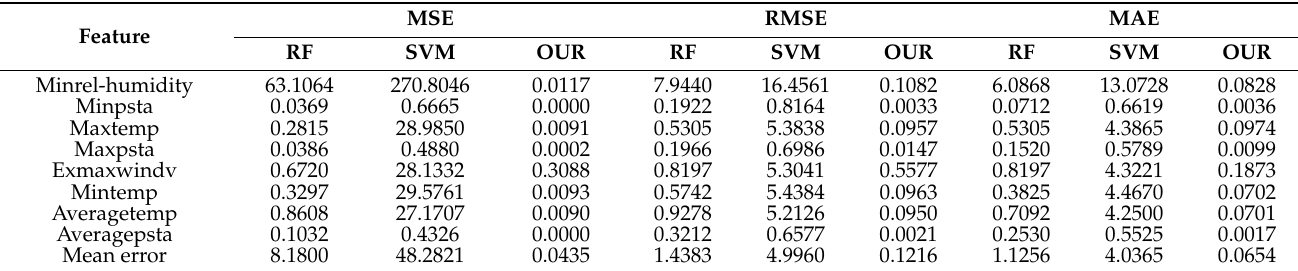
Table 4. Error comparison results of traditional machine learning models.